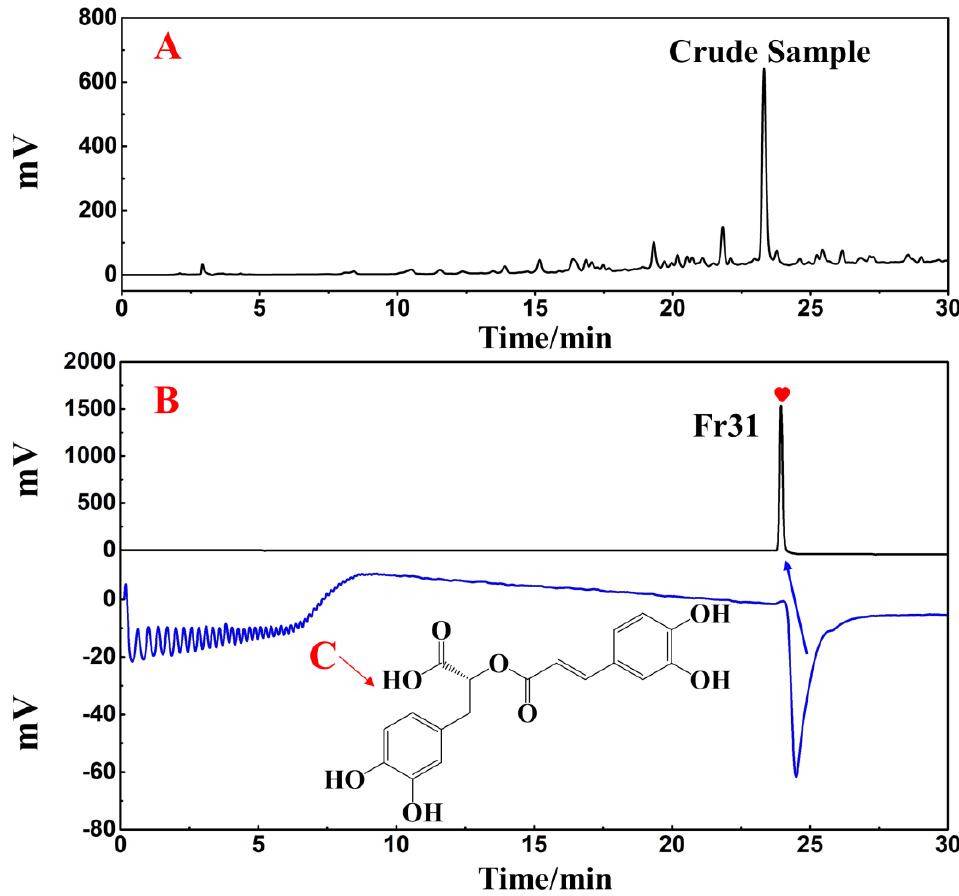
Figure 9. Purity and activity analysis comparison figures of the isolated main component Fr31 ( A , B ) on the SunFire analytical column. ( C ) is the chemical structure of the isolated compound. Antioxidant peak marked with red heart. Conditions: 0.1% formic acid in water, B: MeOH; gradient: 0–30 min, 10–90% B; monitoring wavelength: 210 nm; flow rate: 1.0 mL/min; injection volume: 1 µ L; column temperature: 30 ◦